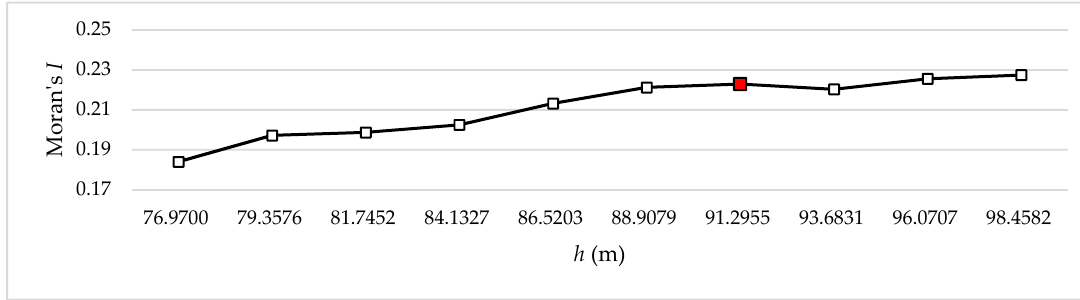
Figure 7. Changes of Moran’s I according to the cluster size at level 12.